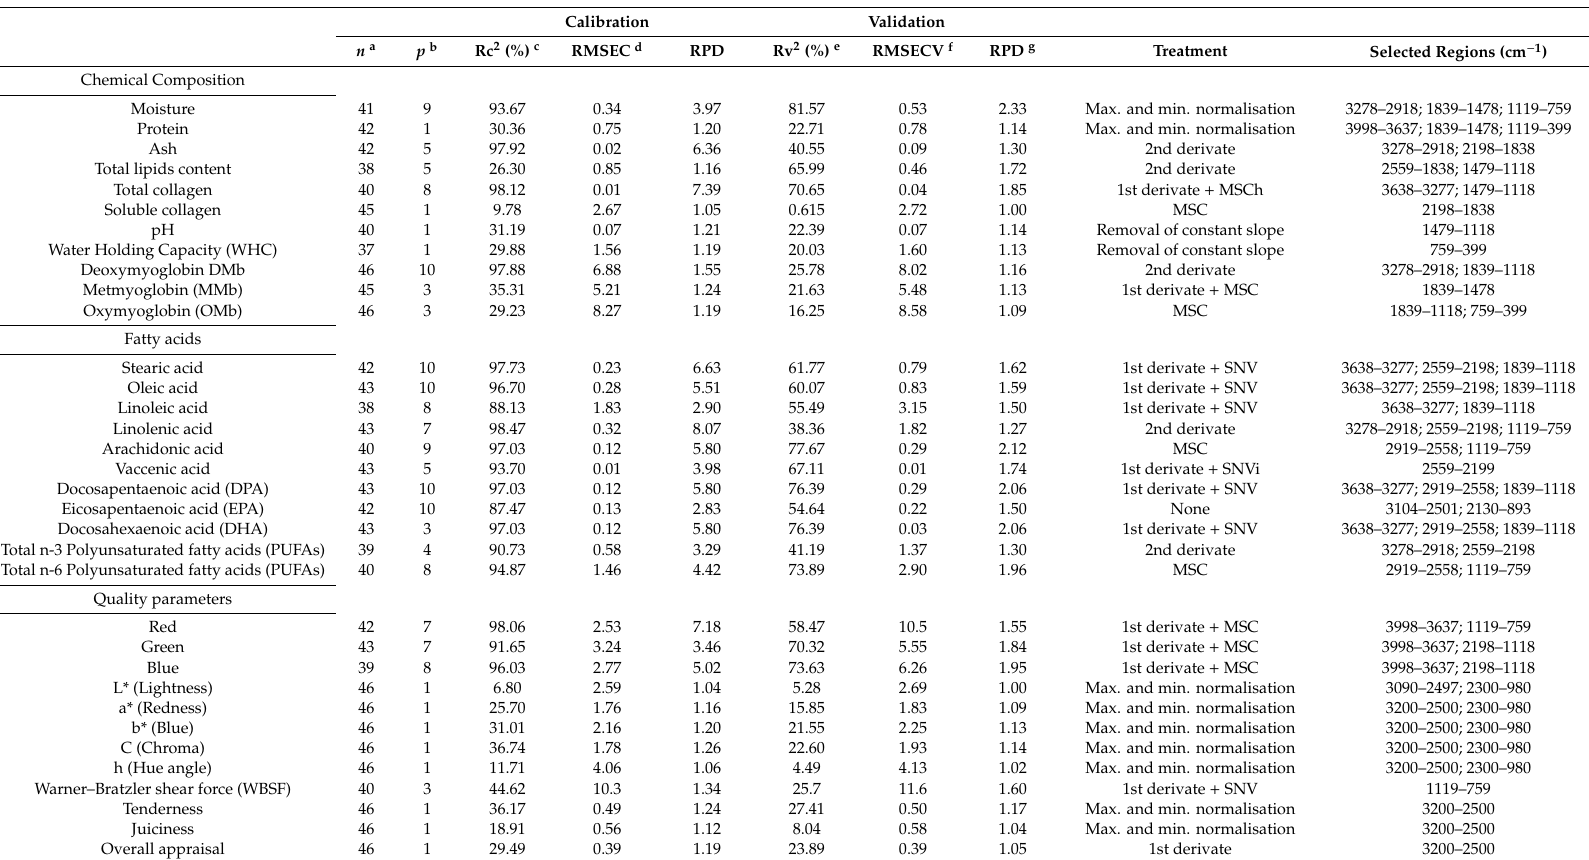
Table 2. Results of the PLS regression models for the MIR data matrix of meat composition and quality from 13- and 26-month-old Galician Mountain x Burguete crossbred foals (13M, 26M) supplemented with standard and linseed